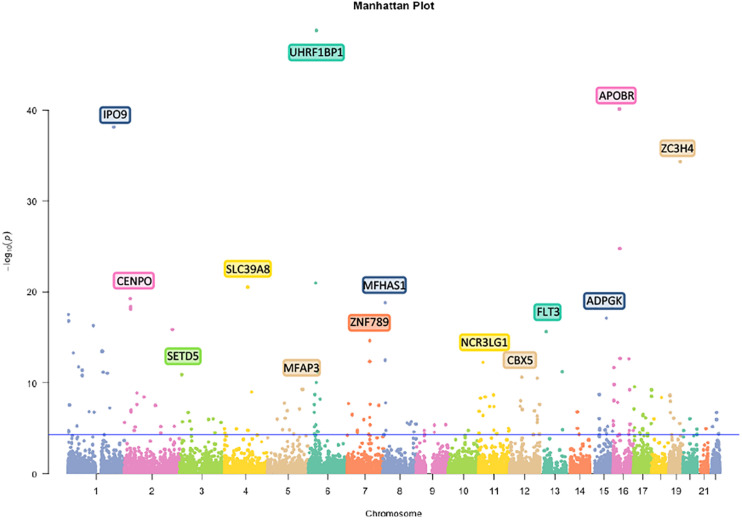
Manhattan plot of genome-wide identified BMI-associated m6A-SNPs. The Manhattan plot showed –log10(p.value) for each of 20993 m6A-SNPs associated with BMI. SNPs with association p.value less than 5.0E-05 was set as a suggestive threshold.